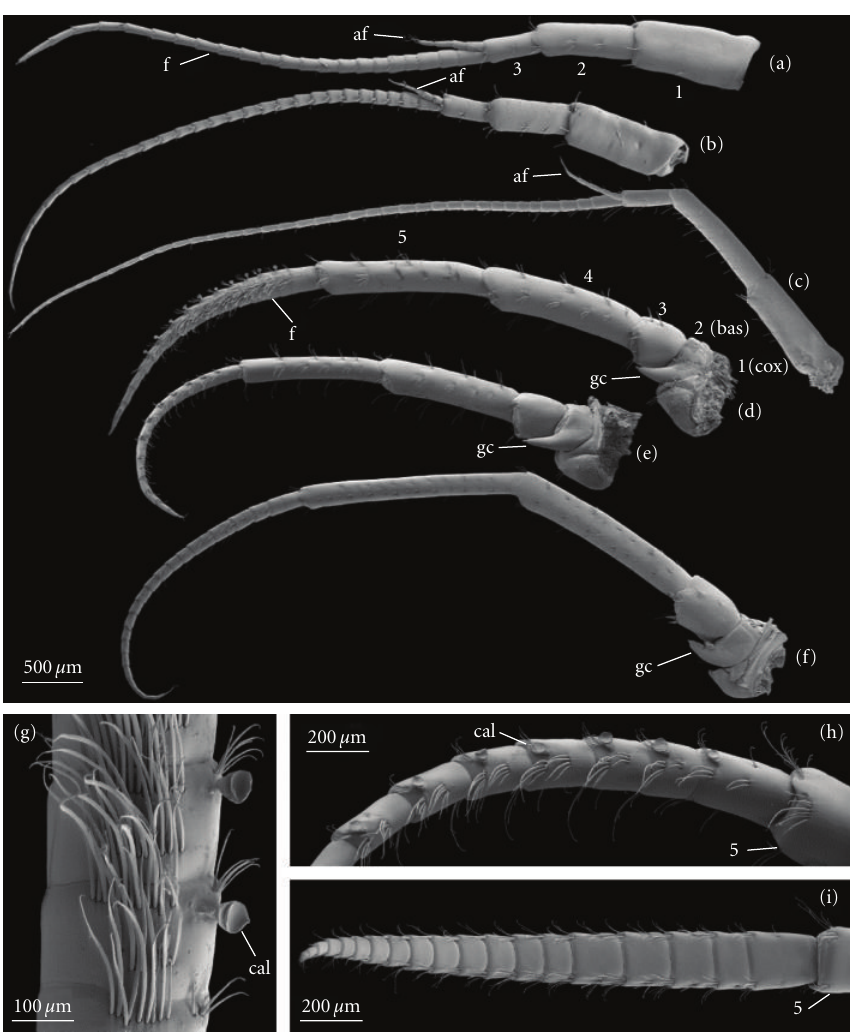
Figure 2: : SEM images of antennulae and antennae: (a–c) right antennula in median view of (a) Gammarus pulex , (b) Gammarus fossarum , and (c) Echinogammarus berilloni ; (d–f) right antenna in median view of (d) G. Pulex , (e) G. Fossarum , and (f) E. berilloni ; (g) proximal part of right antenna of G. pulex in posterior view; (h) proximal part of flagellum of right antenna of G. fossarum in median view; (i) flagellum of left antenna of E. berilloni in posterior view. af: accessory flagellum; bas: basipod; cal: calceolus; cox: coxa; f: flagellum; gc: gland-cone; 1, 2, 3, 4, 5: number of podomeres of